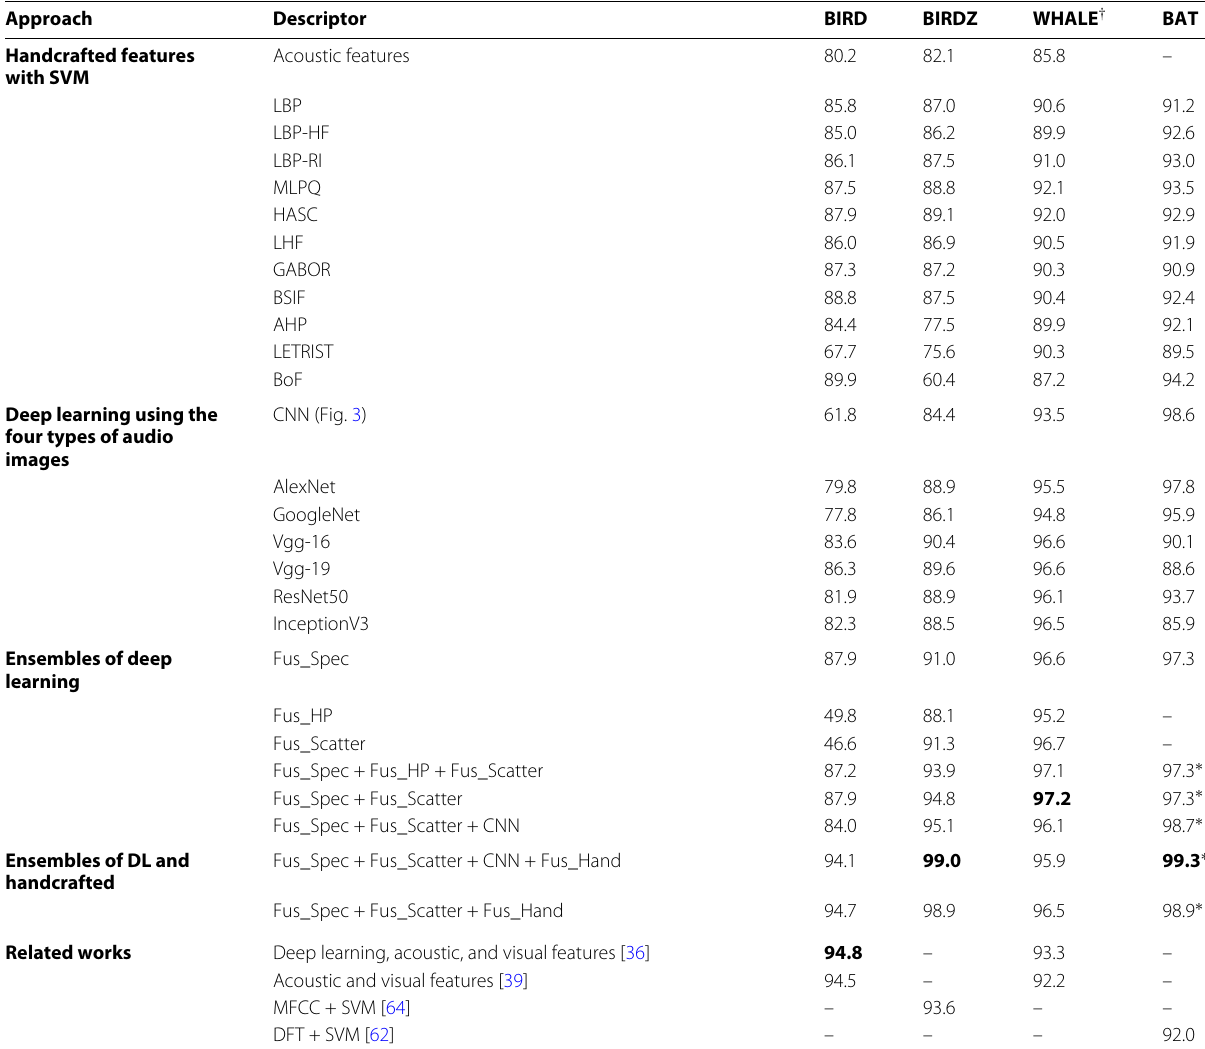
Table 3 Performance of different approaches on each animal sound dataset Approach Handcrafted features with